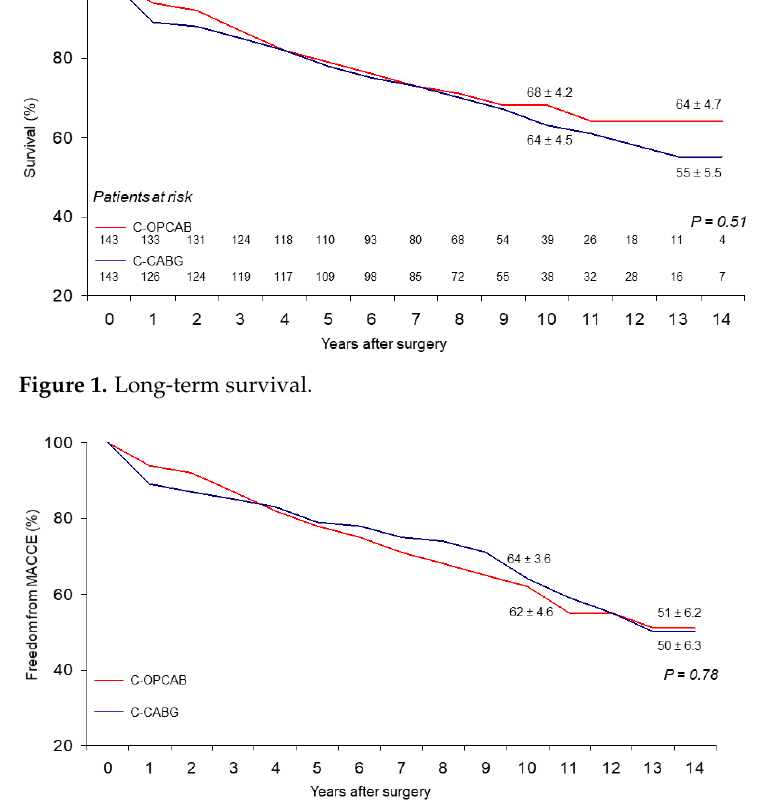
Figure 2. Freedom from MACCEs (MACCEs = Major Adverse Cardiac and Cerebrovascular Events).